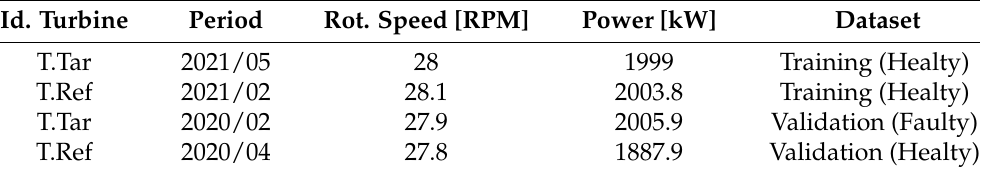
Table 3. Vibrational events considered for the